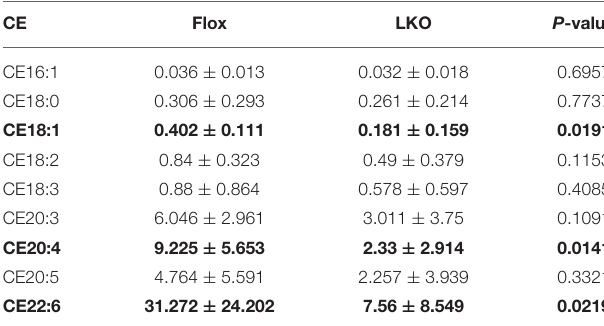
Lipids were extracted from the adrenal gland using MTBE and then analyzed with LC- MS/MS. Relative quantification of lipids in samples was carried out based on the intensity of each species divided by the intensity of the internal standard (CE17:0) and protein concentrations. Values of all data were mean ± S.D. The significance was defined as p < 0.05 (shown in